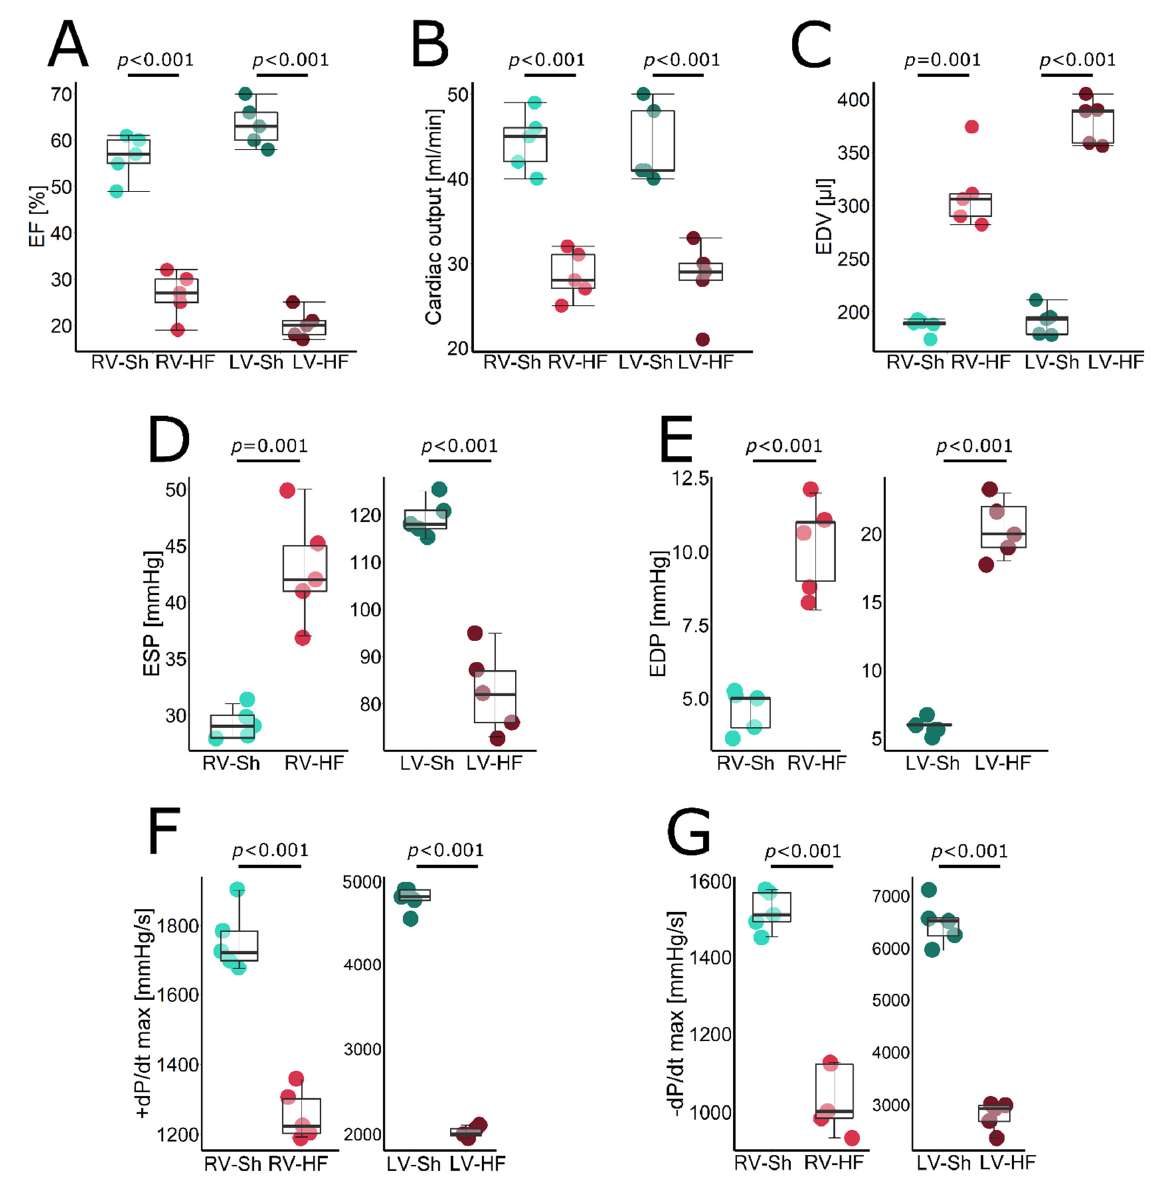
Figure 1. Pressure-volume-loop-derived hemodynamic parameters in LV and RV of sham-operated (Sh) and heart-failure (HF) rats. ( A ) Ejection fraction (EF), ( B ) cardiac output (CO), ( C ) end-diastolic volume (EDV), ( D ) end-systolic pressure (ESP), ( E ) end-diastolic pressure (EDP), ( F ) maximal slope of systolic pressure increment (+dP/dt max), ( G ) maximal slope of diastolic pressure decrement ( − dP/dt max). Data presented as median, Q1, Q3, max and min values. Since arterial elastance (Ea), a marker of arterial component of LV afterload, was in- creased and contractility was impaired, a very sensitive index of LV ventricular–arterial coupling (Ea/ESPVR) was increased by more than five-fold, indicating severe uncoupling (Figure 2C). Markedly increased lung weight, a marker of lung congestion, indicated symptomatic LV heart failure (Table 1), accompanied by reduced LV ESP (Figure 1D) and